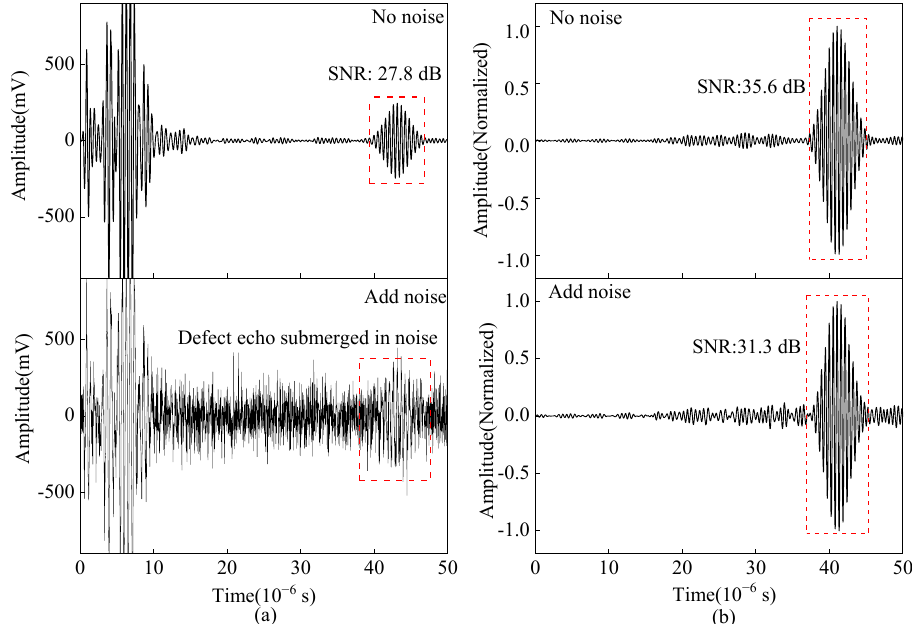
Figure 19. Experimental ultrasonic signal from angled SV wave EMAT with ( a ) tone-burst excitation method ( b ) Barker code pulse compression technique.